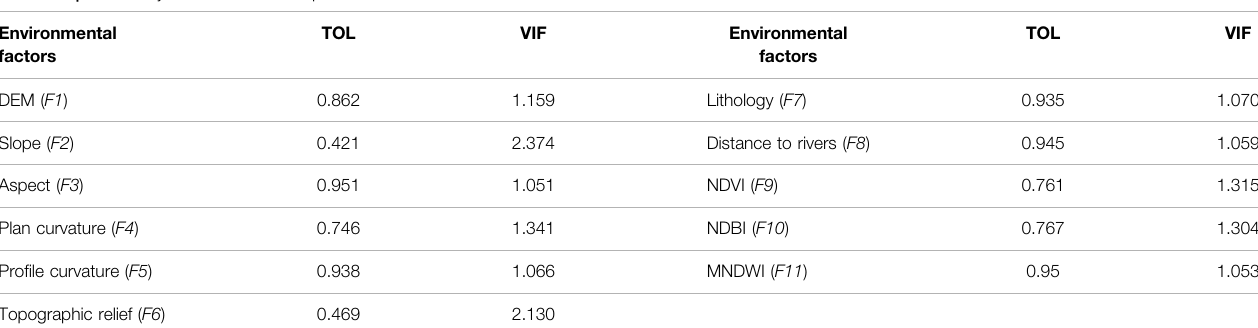
value of TOL is 0.421, indicating that there is only small multicollinearity among the collapse-related environmental factors; hence, all 11 input factors can be used to predict the collapse susceptibility of the study area.